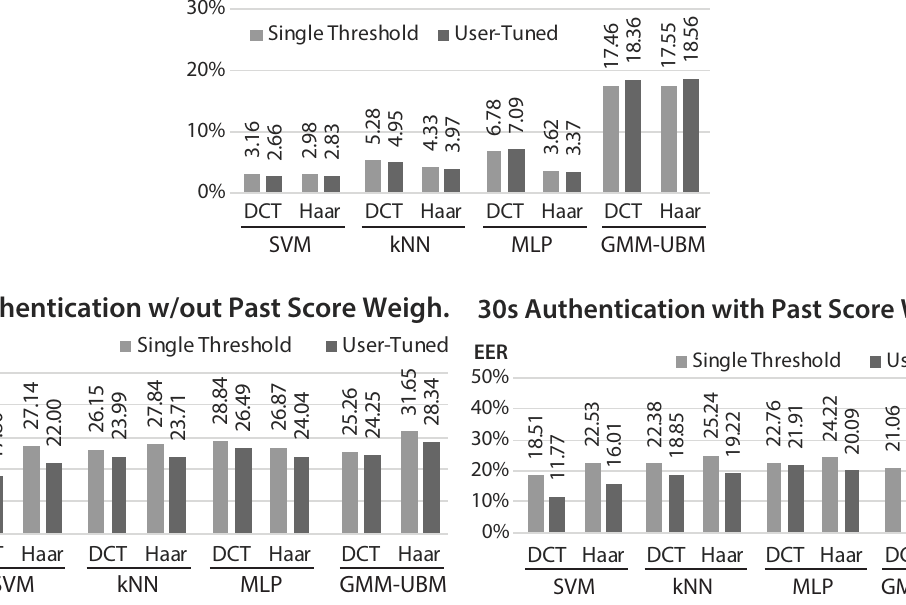
Figure 7. Equal error rate (EER) results of the proposed method in authentication tasks, with and without user-tuned thresholds (top: results with 70-30 dataset split; bottom-left: results with 30 s train; bottom-right: results with 30 s train and past score